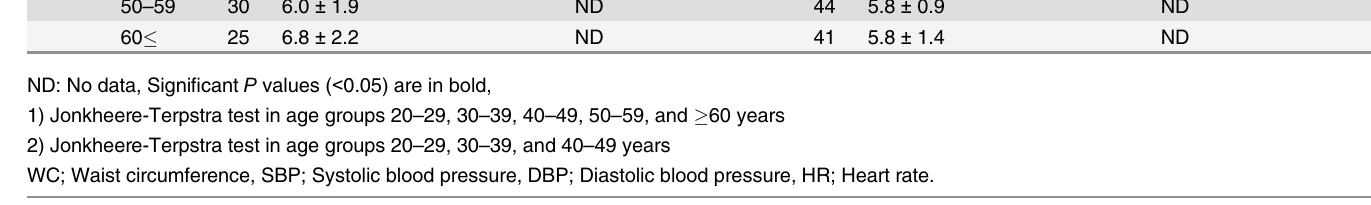
Table 4. A comparison of Lao Loum anthropometric and clinical data collected 5 years apart.